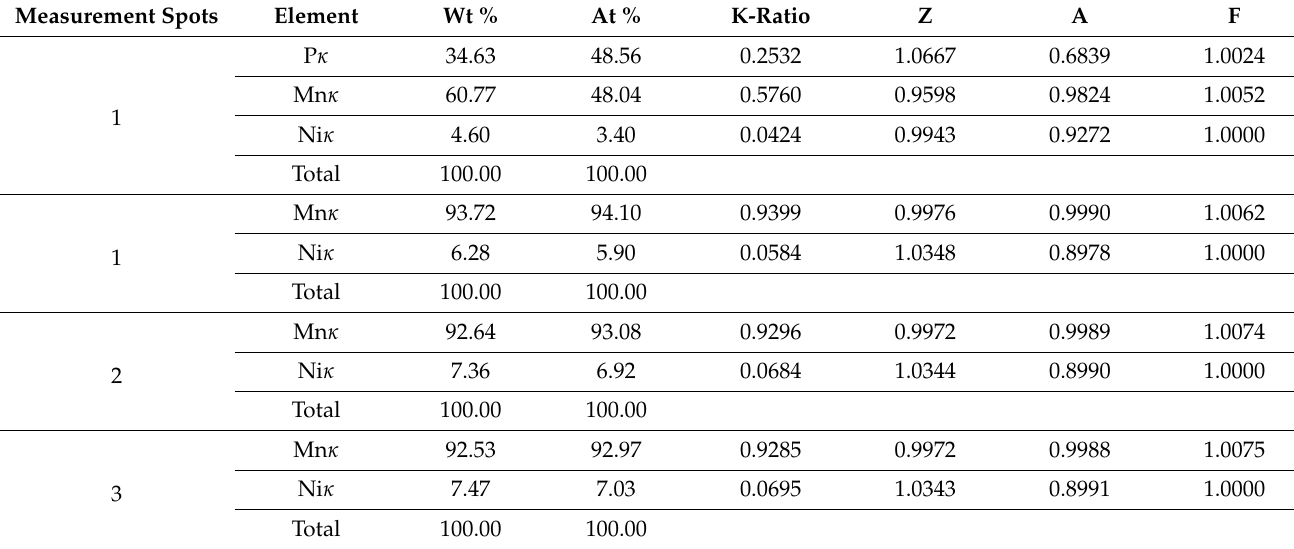
Table 1. The chemical compositions collected on the three spots on the (001) surface of the Li(Mn 0.95 ,Ni 0.05 )PO 4 crystal. Measurement Spots Element Wt % At % K-Ratio Z A F